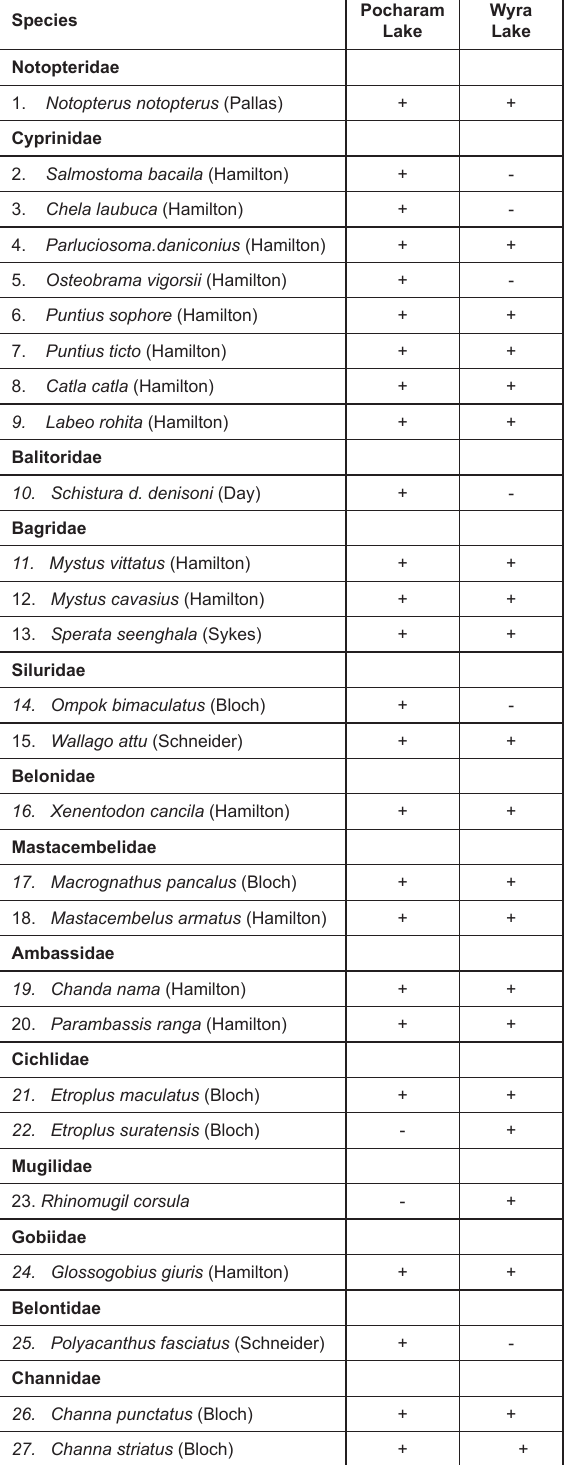
Table 1. List of fish species occurring in Pocharam and Wyra